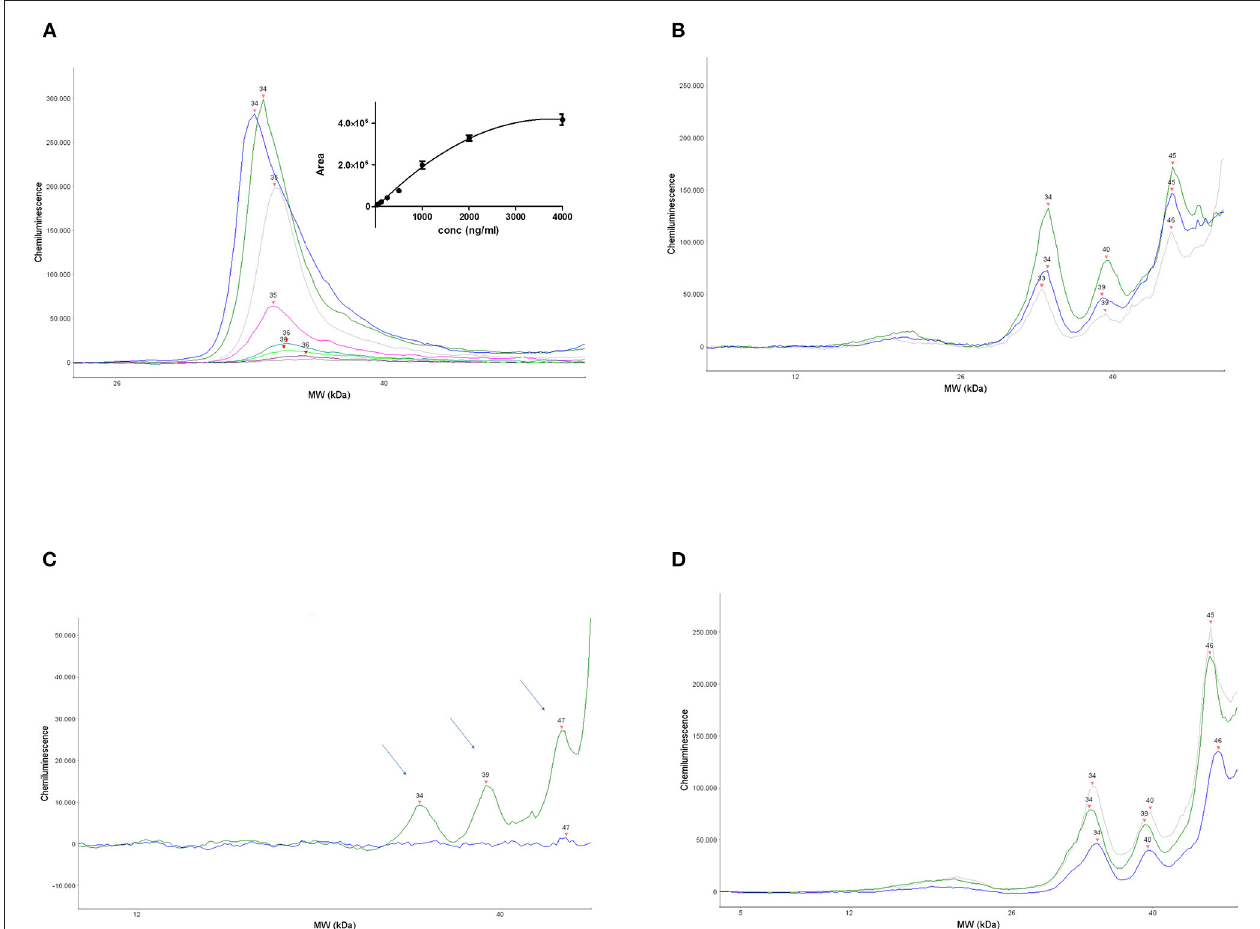
FIGURE 1 | Set up and validation of the immunoassay. (A) A representative calibration curve obtained by serial dilutions of human recombinant proNGF. Main panel: overlapped electropherograms of the different concentrations of proNGF from Simple Wes runs. Inset panel: interpolation by a polynomial curve of the values of the area under the peaks for each proNGF concentration. Dynamic range (4,000–31 ng/ml). (B) Three representative electropherograms of CSF samples from three different patients with AD. (C) Electropherograms obtained from the immunodepletion experiment. A CSF sample from the same patient was divided into two aliquots: one aliquot was processed normally and the other one was immunoprecipitated by α D11 and then processed. The immunodeprived sample (blue electropherogram) and the normal processed sample (green electropherogram) were run side by side on Simple WES. The arrows indicate the three peaks that disappear in the immunodeprived sample. (D) Three representative electropherograms of CSF samples from an AD patient (blue), an SMC subject (gray), and a control subject